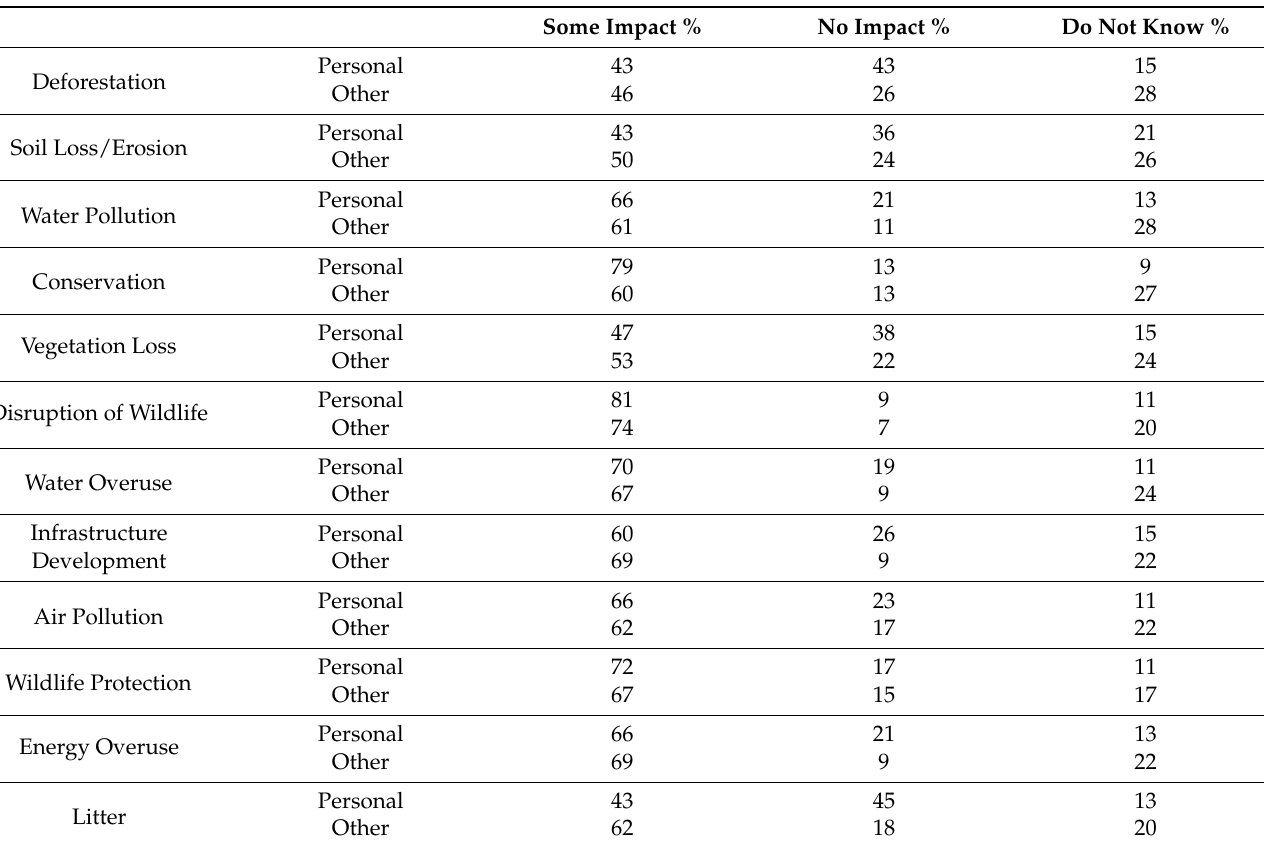
Table 2. Comparison of the perception of tourists’ own impacts on the environment and their perception of other tourists’ impacts.